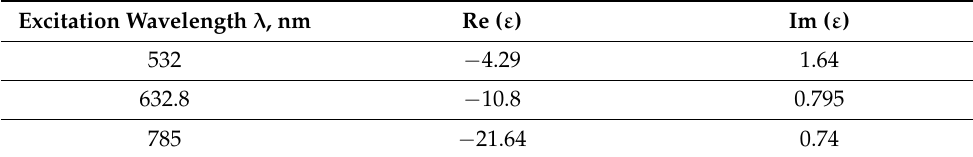
Table 1. Electric field simulation parameters for NR without SiO 2